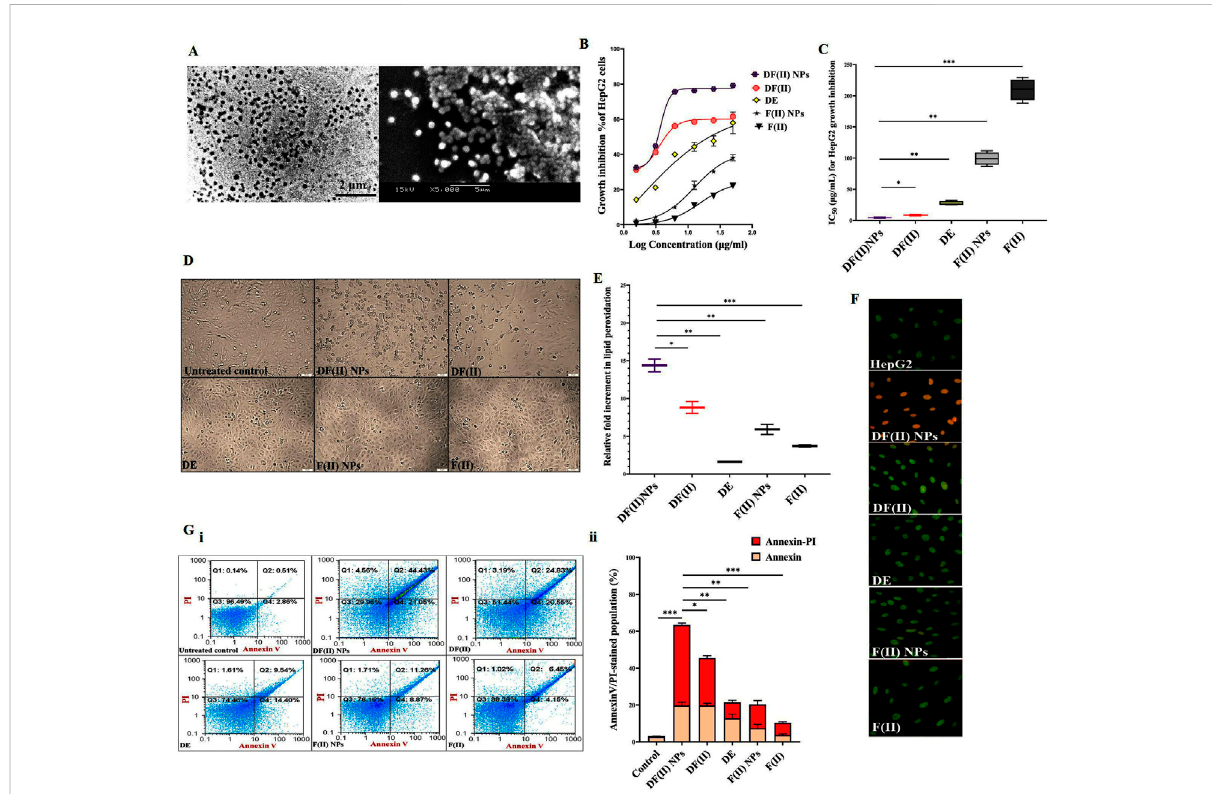
FIGURE 1 Morphology of ferrous oxide nanoparticles-diethyldithiocarbamate nanocomplex (DF(II) NPs) and its anticancer activity ( in vitro study). (A) Micrograph of DF(II) NPs using transmission electron microscope (left image) and scanning electron microscope (right image) at magni fi cation ×5000). MTT results of HepG2 growth inhibition as illustrated by (B) dose-response curve of both complexes, diethyldithiocarbamate (DE), ferrous oxide nanoparticles (FII NPs), and ferrousoxide(F(II)) and (C) their IC 50 values with (D) morphological alterations ofDF(II) NPs- and DF(II)-treated HepG2 cells using phase contrast microscope (Magni fi cation ×100). (E) Relative fold increment in lipid peroxidation in the treated HepG2 cells. All values are demonstrated as mean ± SEM. DF(II) NPs-treated cells were compared to other treated cells and the differences were considered signi fi cant at p ≤ 0.05*, ≤ 0.005**, and ≤ 0.001*** (F) Fluorescence microscope after staining with acridine orange/ethidium bromide (Green, yellowish green and orange fl uorescences indicating for viable, early death and late death stage cells, respectively). (G) Flow cytometry analysisofthetreatedHepG2cells,afterstainingwithannexinV/propidiumiodide(annexin/PI)asshowedby (i) dotplots(Q1,Q2,Q3,andQ4referto propidium iodide (PI)-stained cells (PI & annexin V) dual stained cells at the late death stage, negatively stained healthy cells, and annexin-stained early apoptotic cells, respectively) and (ii) the percentages of annexin- and annexin/PI-stained cell populations. All values are demonstrated as mean ± SEM. DF(II) NPs-treated cells were compared to other treated cells and the differences were considered signi fi cant at p ≤ 0.05*, ≤ 0.005**, and ≤